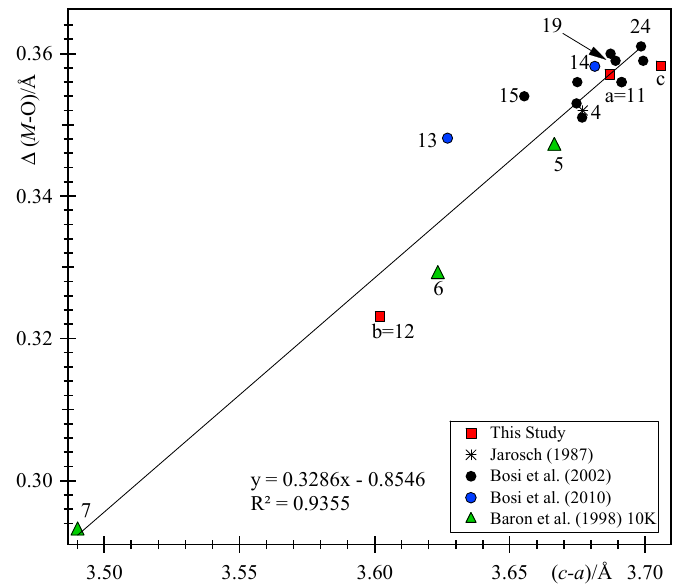
Figure 6. Linear variation of Jahn–Teller elongation, Δ ( M –O), with the difference in unit-cell parameters, ( c-a ). The ( c - a ) value becomes smaller as Δ ( M –O) becomes smaller. Cubic hausmannite contains no Jahn–Teller elongation, so ( c - a ) = 0. The trend line is fitted to all the plotted data (4–7 and 11–25; Table 1). Samples-c and -24 contain the most distortion from cubic symmetry, whereas sample-b contains the least distortion. Sample-7 at 10 K contains the least distortion of all the samples. The Mg-rich sample-13 has a small distortion.